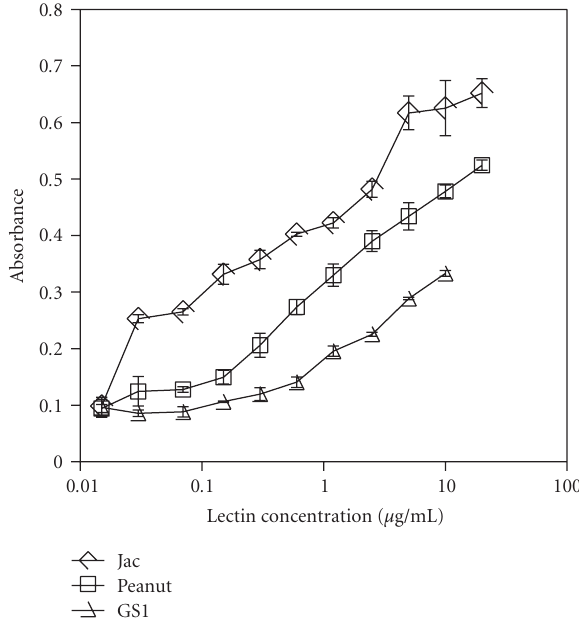
Figure 3: ELISA plates were coated with MUC1 peptide. Wells were then blocked with blocking bu ff er (PBS + Ca / Mg and 1% BSA) and various concentrations of Lectins were added. Plates were incubated for two hours washed and binding was visualized by Streptavidin-